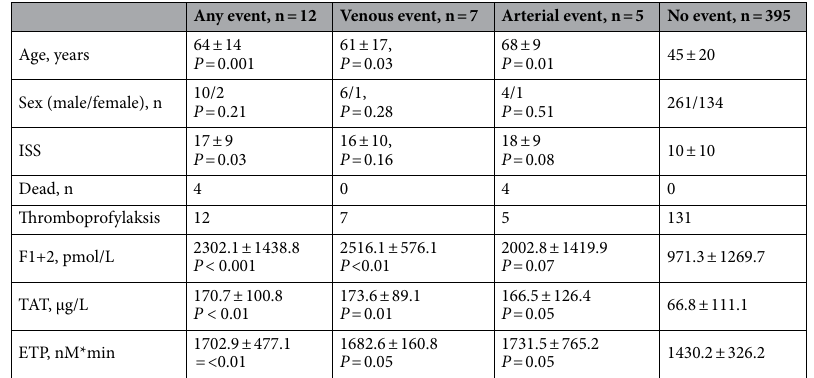
Table 5. Characteristics of patients with thromboembolic events. Admission charateristics of patients experiencing symptomatic thromboembolic events within 30 days of the trauma. Any event are pooled data for venous and arterial events. Each group (any, venous, arterial) are compared with “no-event”. The “no-event” group excludes non-survivors. Abbreviations: ETP endogenous thrombin potential, F1+2 prothrombin fragment F1+2; ISS Injury Severity Score; TAT: Thrombin-antithrombin complex levels. Data presented as mean ± sd unless stated